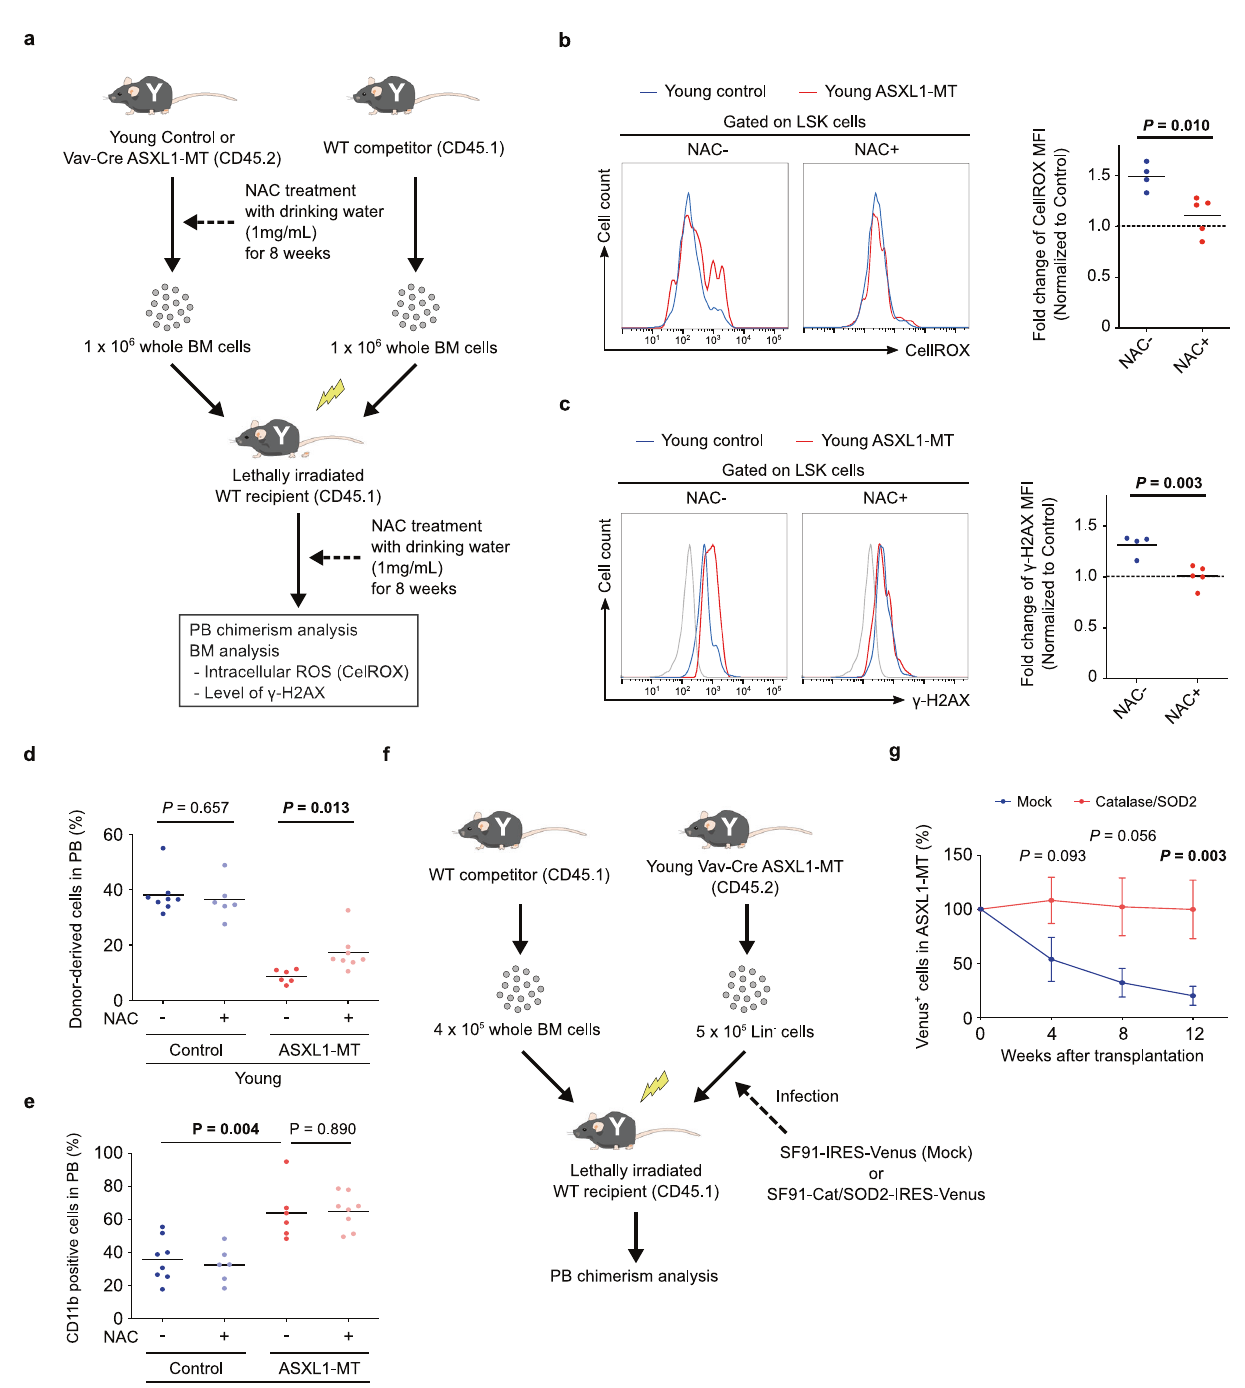
Fig. 8 ROS-mediated DNA damage causes dysfunction of LT-HSCs. a The experimental design for transplantation using whole bone marrow cells treated with an antioxidant scavenger NAC. Whole bone marrow cells isolated from young control and young Vav-Cre ASXL1-MT KI mice that had been treated with NAC for 8 weeks were transplanted into lethally irradiated recipient mice with competitor cells. Recipient mice were continuously treated with NAC after transplantation. b , c 6 weeks after transplantation, effects of NAC administration on ROS ( b ) and γ -H2AX levels ( c ) in LSK cells were determined ( n = 4 (NAC − ) and 5 (NAC + )). d , e The frequencies of donor-derived cells ( d ) and CD11b-positive cells in donor-derived cells ( e ) in peripheral blood were analyzed ( n = 8 (Control-NAC − ), 6 (Control-NAC + ), 6 (ASXL1-MT-NAC − ), and 8 (ASXL1-MT-NAC + )). f The experimental design for transplantations using Lin − cells transduced with ROS-detoxifying enzymes. Lin − cells from young Vav-Cre ASXL1-MT KI mice transduced with control or Catalase-SOD2 retrovirus were transplanted into lethally irradiated recipient mice. g Engraftment was assessed at the indicated weeks after transplantation ( n = 7 (Mock) and 8 (Catalase-SOD2)). Data are mean ± s.e.m. Statistical signi fi cances are assessed by two-tailed Student ’ s t -test. * P ≤ 0.05, ** P ≤